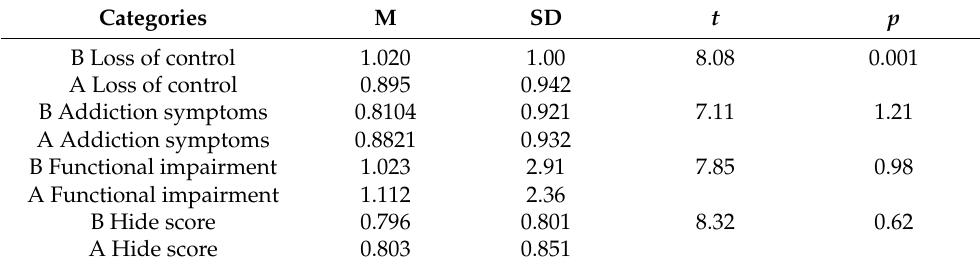
Table 4. Paired t -test related to the four SAST categories before (B) and after (A) the pandemic.